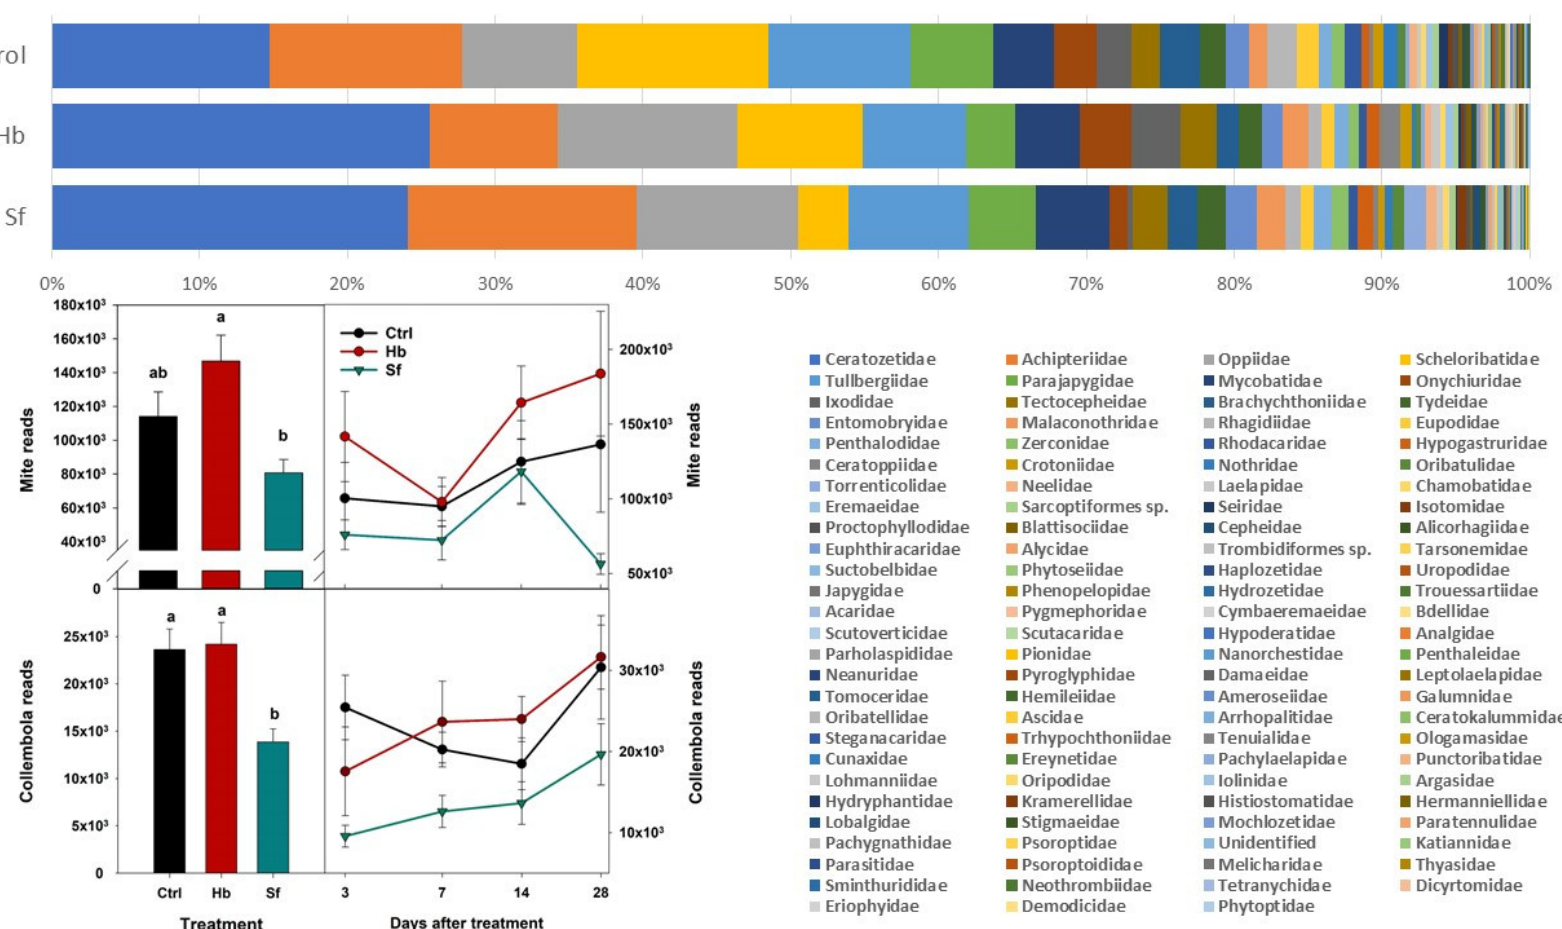
Figure 3. Results of DNA metabarcoding of soil microarthropod communities. Upper panel: Stacked bar plots showing the relative abundance of microarthropod families ( listed lower right ) detected in a citrus orchard for 28 days following augmentation with Steinernema feltiae (Sf) , Heterorhabditis bacteriophora (Hb) and an untreated control (Ctrl). Lower left: Bar plot of two dominant groups acari mites and springtails read abundance in each treatment. Lower center: Temporal trends in acari mites and springtails read abundance in the treatments for 28 days following augmentation. Error bars are standard errors of the mean, bars with the same letters do not differ ( p < 0.05).